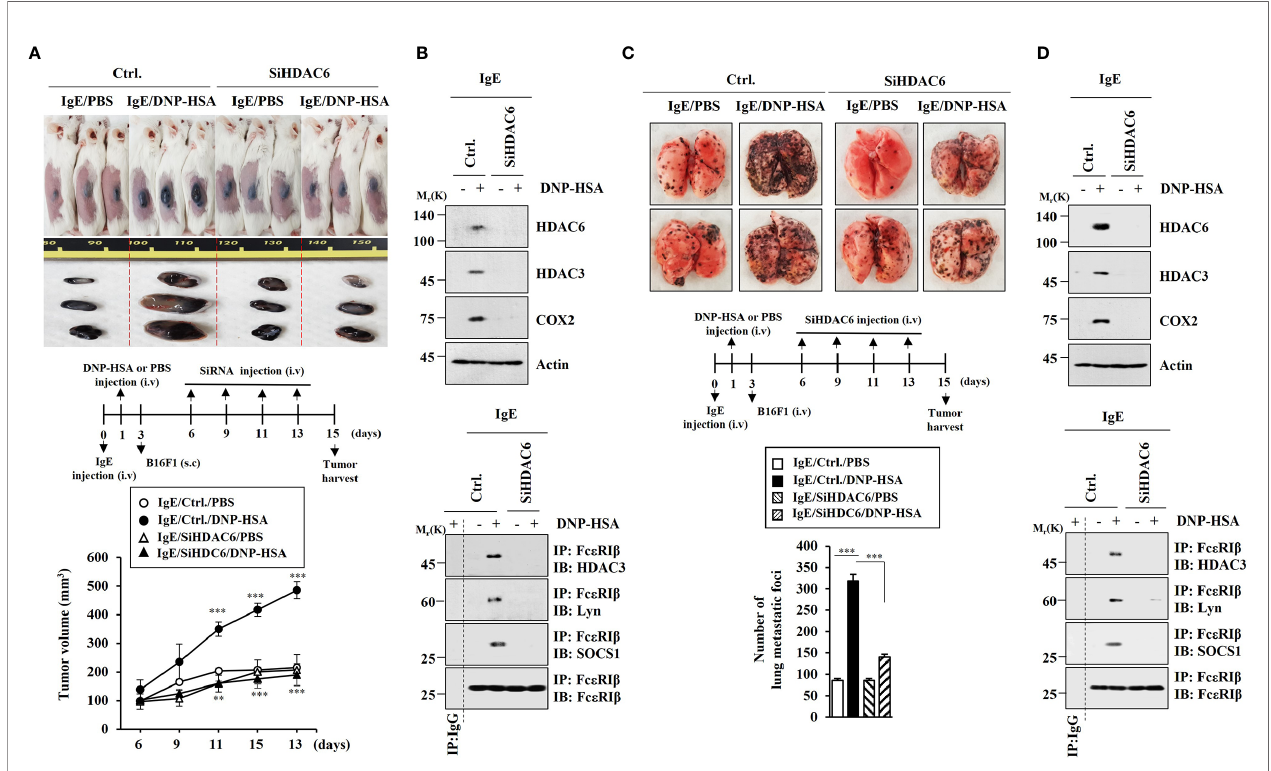
FIGURE 7 | HDAC6 is necessary for tumorigenic and metastatic potential enhanced by PSA. (A) PSA was induced as described. Each mouse was given an injection with B16F1 melanoma cells (2 × 10 5 ) on day 3 of the time line. After tumor reached a certain size, each BALB/C mouse was intravenously injected with the indicated siRNA (each at 3 m g/kg) on the indicated days. Each experimental group comprised four BALB/C mice. ** p <0.01, compared with IgE/Ctrl./DNP-HSA; *** p <0.001, compared with IgE/Ctrl./PBS (B) Immunoblot and immunoprecipitation employing tumor tissue lysates were performed (n=4). Representative blots of three independent experiments are shown. (C) Each mouse was injected with B16F1 melanoma cells (2 × 10 5 ) on day 3. The number of lung metastatic foci was determined. Each experimental group comprised four BALB/C mice. *** p <0.001. (D) Immunoblot and immunoprecipitation employing tumor lysates were performed (n=4). Representative blots of three independent experiments are